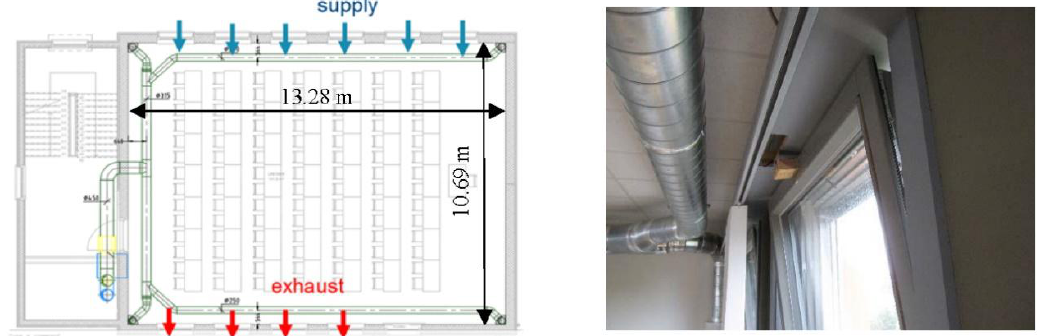
Figure 4. Principle of natural night ventilation ( left ) and detail of motorized window (1.29 × 1.38 m², maximum opening angle of 8.8°) ( right ).